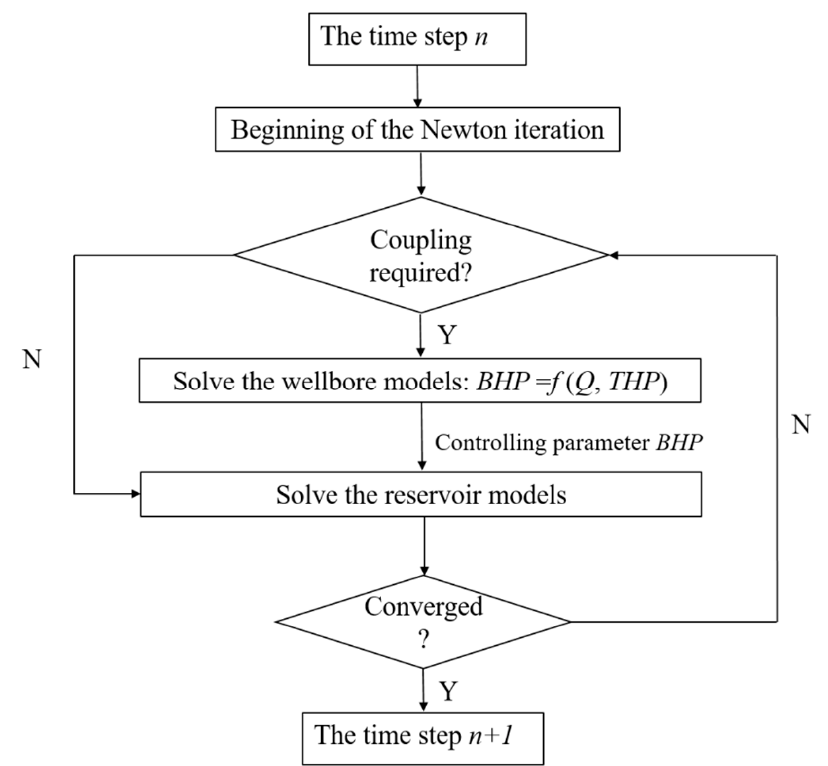
Figure 5. Schematic of the implicit coupling scheme.